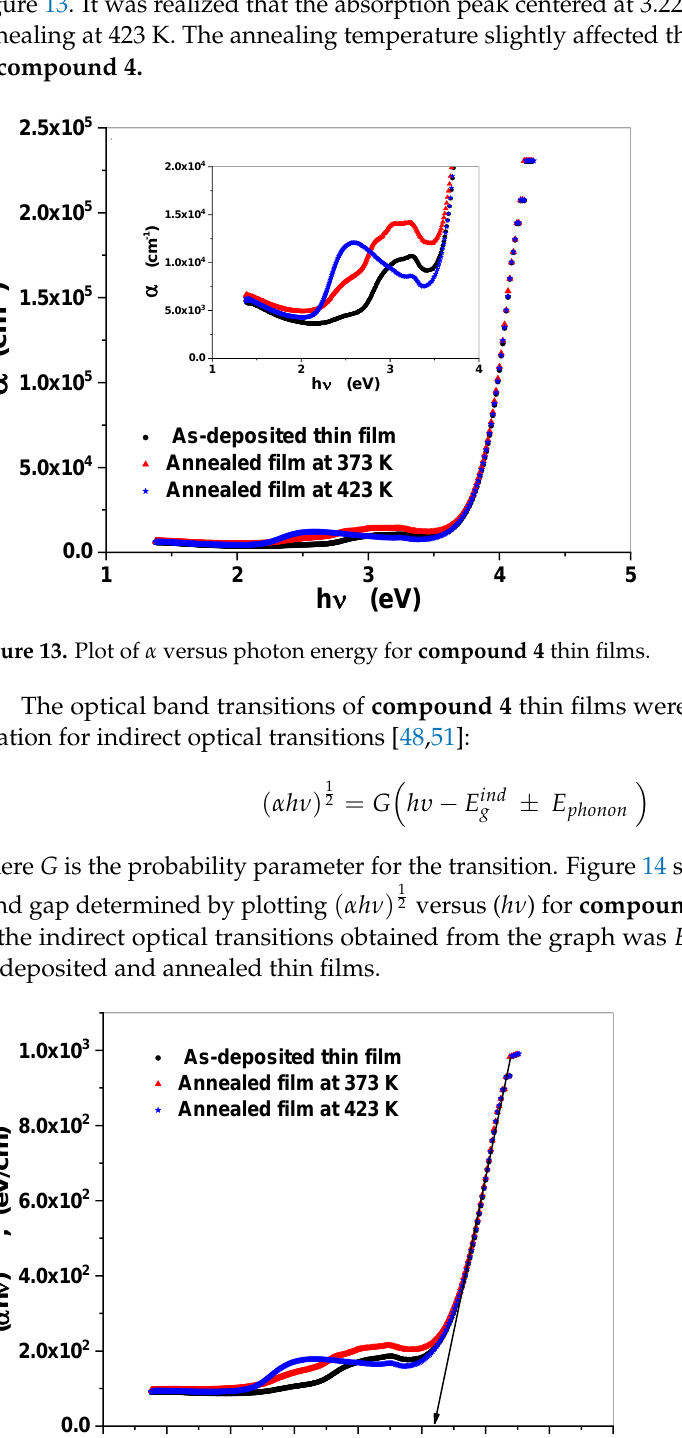
Figure 12. Optical transmittance (T) and reflectance (R) of compound 4 thin films. The absorption coefficient spectra ( 𝛼 ) of the compound 4 thin films are shown in Figure 13. It was realized that the absorption peak centered at 3.22 shifted to 2.52 eV due to annealing at 423 K. The annealing temperature slightly affected the sharp absorption edge of compound 4.